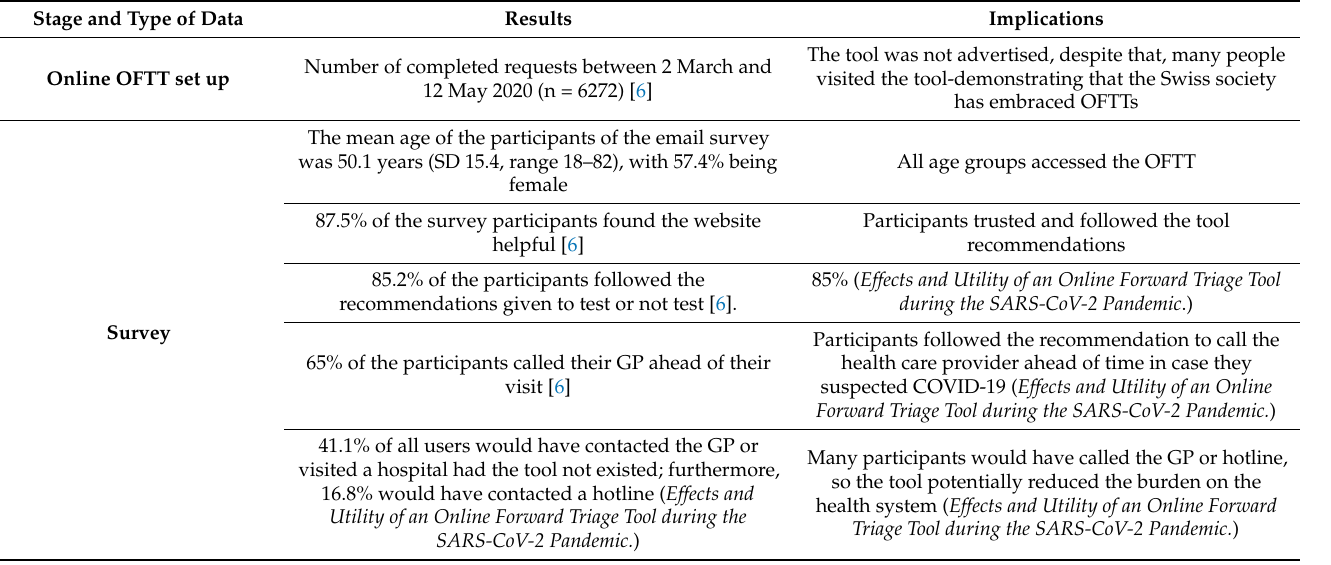
Table 2. Data sources and implications for an